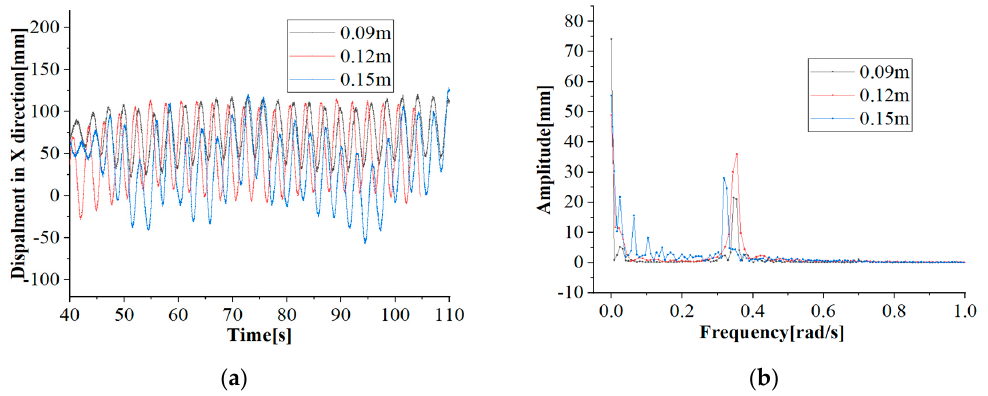
Figure 16. Surge response of the pedestal with different wave heights at 0.35 Hz. ( a ) Surge; ( b ) surge frequency domain curve.